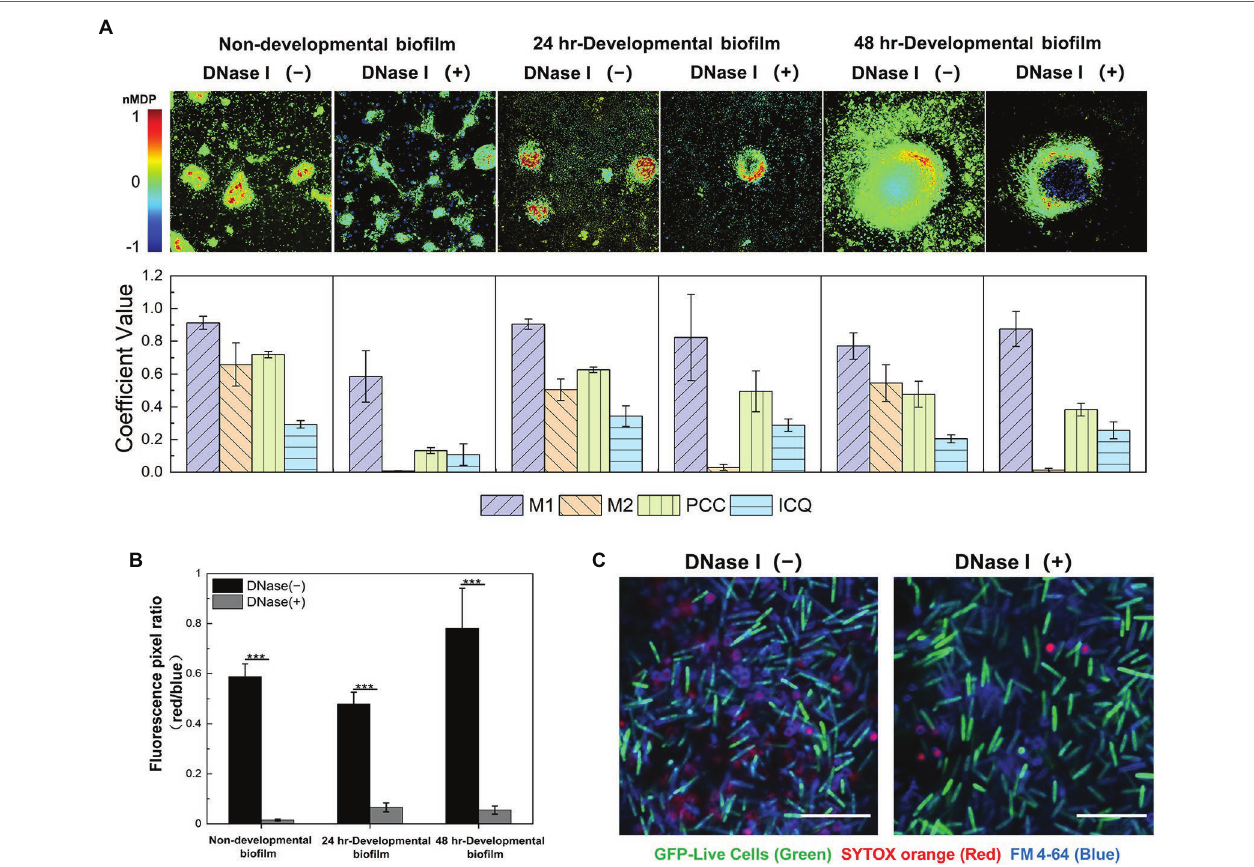
FIGURE 1 | eDNA colocalizes with exopolysaccharides (EPS) in the extracellular matrix (ECM) of both non-developmental and developmental Myxococcus xanthus biofilms. (A) Quantitative colocalization analysis of the STYOX orange and Alexa 350-conjugated WGA fluorescent signals. The colocalization colormap is shown in the upper panel. The hot color represents a positive correlation, and the cold color represents a negative correlation. Further color divisions within groups are indicated by the color scale bar. In the lower panel, the histogram was generated from the calculated colocalization coefficient (M1 and M2), Pearson’s correlation coefficient (PCC), and an intensity correlation quotient (ICQ; n = 5). (B) The fluorescence pixel ratio (red/blue) of the samples with/without DNase I treatment. The significance was determined by Student’s t -test ( n = 5; *** p < 0.001). (C) The non-developmental biofilm (24 h) formed by Myxococcus xanthus DK10547 (live cells, GFP-green) was stained with SYTOX orange (eDNA and dead cells, red) and FM 4-64 (cell membrane, blue). Scale bars represent 20 μ